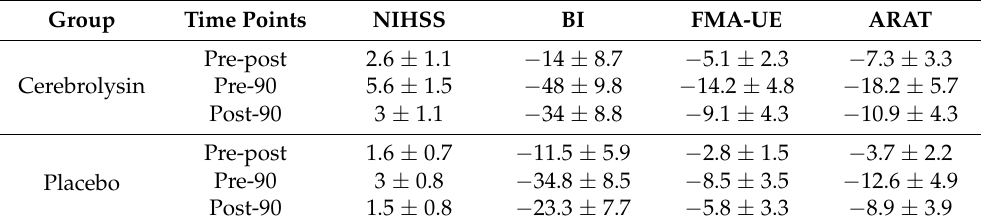
Table 5. Changes in outcomes over time in the Cerebrolysin group and Placebo